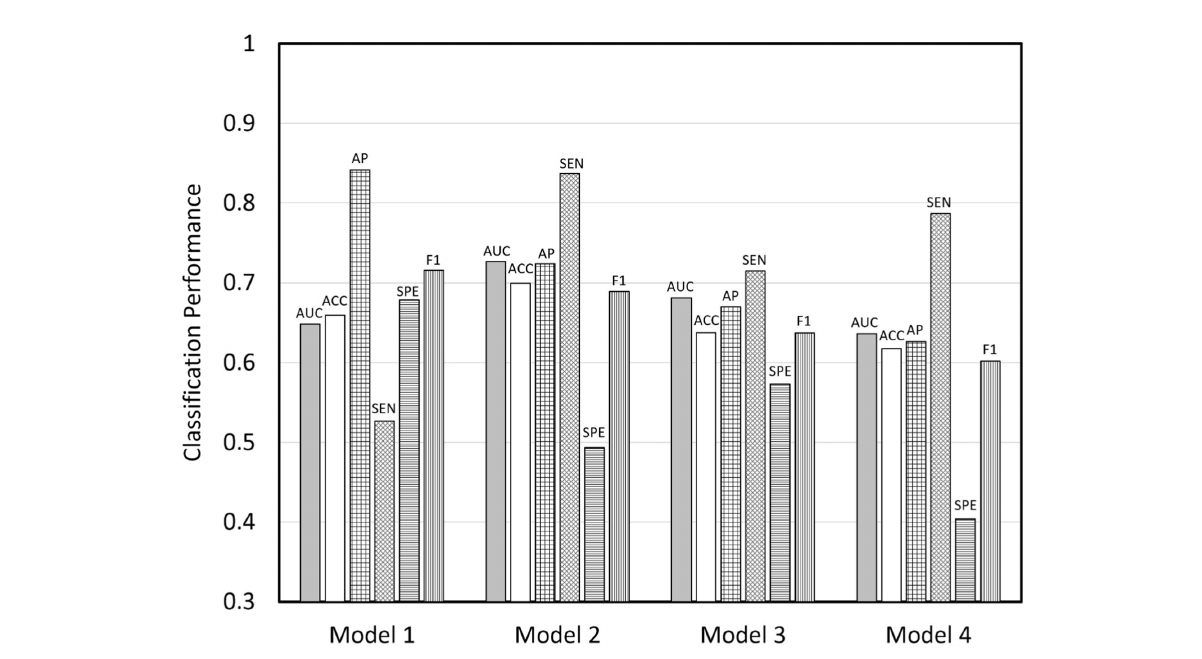
FIGURE 1 Bar charts showing the performance of the four prediction models. AUC, area under receiver operating characteristic curve; ACC, accuracy; AP, average precision; SEN, sensitivity, SPE, specificity; F1, F1